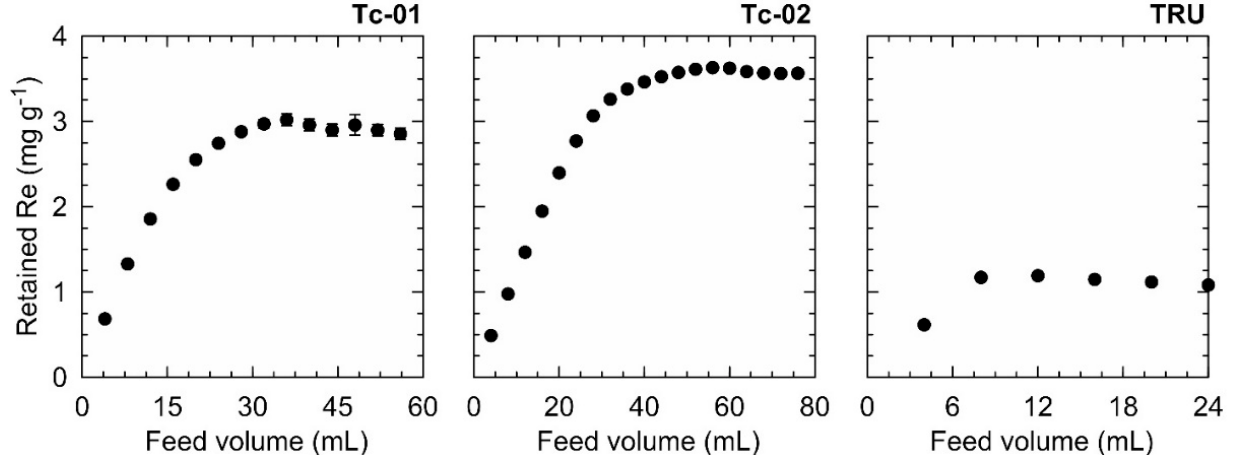
Figure 3. Re retention capacities of the ECRs (Feed solution volume, ~100 mL; C Re , 0.08 mg mL − 1 ; solution acidities: Tc-01, pH 1; Tc-02, pH 4; TRU, pH 2); loading flow-rate: 0.5 mL min − 1 ; n = 3).